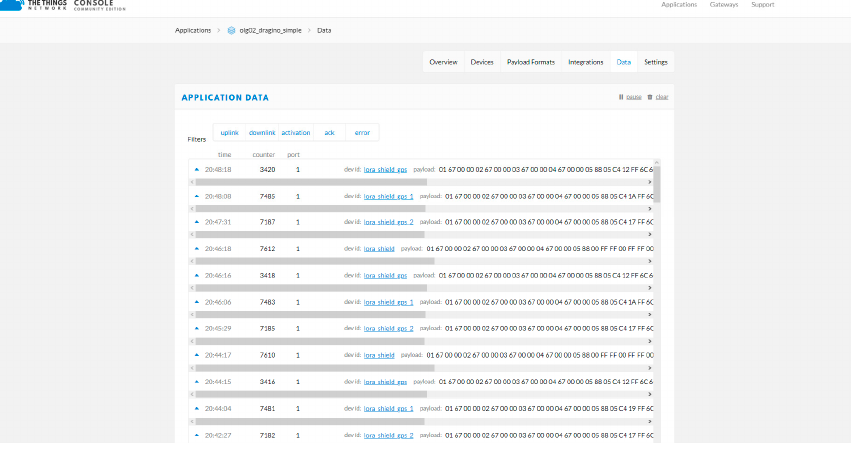
Figure 8. TTN Data Figure 8. TTN Data console.